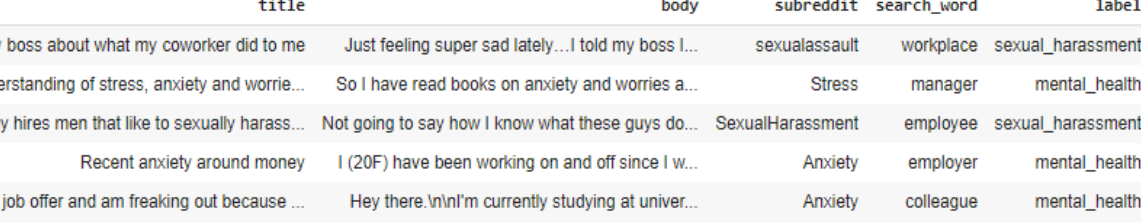
Figure 2 . Overview of five randomly sampled records from the dataset.